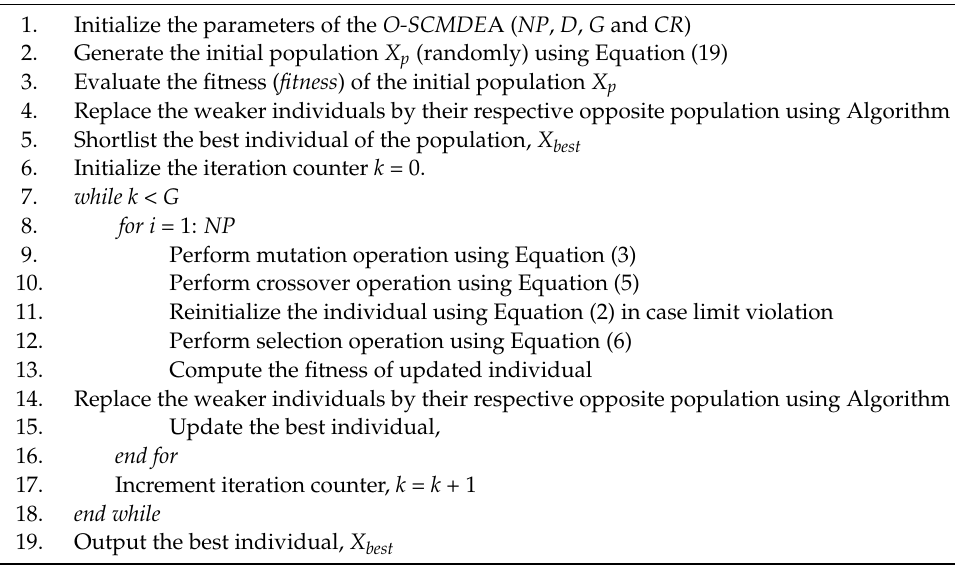
Algorithm 2 Pseudo code of O-SCMDE